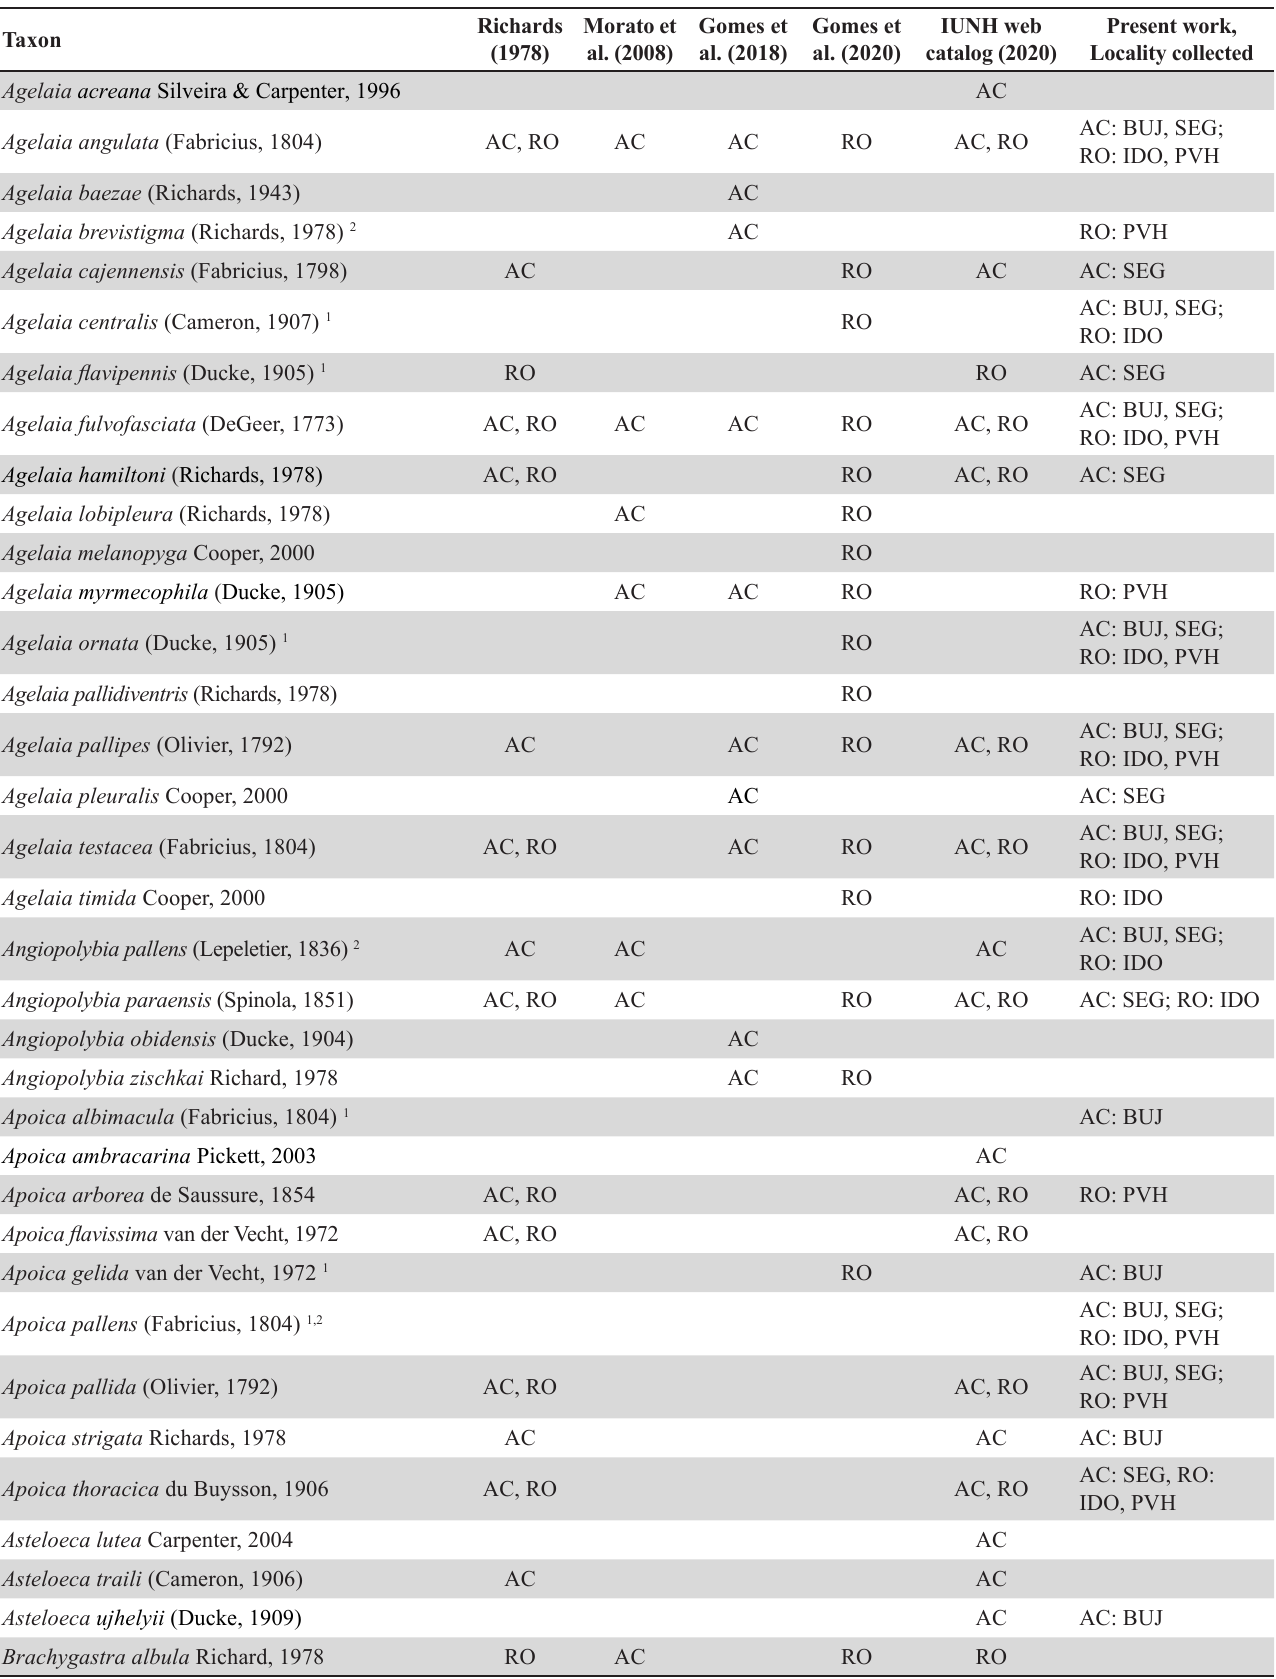
Table 1 . Species of social wasps from Acre and Rondônia states, listed by Richards (1978), Morato et al. (2008), Gomes et al. (2018), Gomes et al. (2020), web catalog from Natural History Laboratory of the Ibaraki University (IUNH 2020), and in the present work. 1 new distribution record for Acre; 2 new distribution records for Rondônia; * distribution records only in the descriptions of the species. AC=Acre; RO=Rondônia; BUJ=Bujari; SEG=Senador Guiomard; IDO=Itapuã do Oeste; PVH=Porto